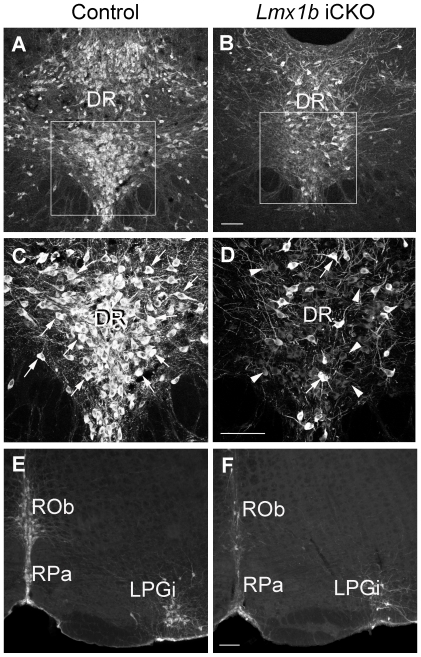
Tph2 expression is reduced in adult Lmx1b iCKO mice.(A–D) The number of DR neurons strongly labeled with Tph2 (arrows in C, D) is decreased in Lmx1b iCKO mice (B, D) compared with wild-type controls (A, C). C and D are high magnifications of the boxed areas in A and B, respectively. Note that most Tph2-positive neurons in Lmx1b iCKO mice are only weakly labeled (arrowheads in D). (E, F) Similar results are observed in the raphe obscurus nucleus (Rob), raphe pallidus nucleus (RPa) and lateral paragigantocellular nucleus (LPGi) of the medulla oblongata. Scale bars, 100 µm.